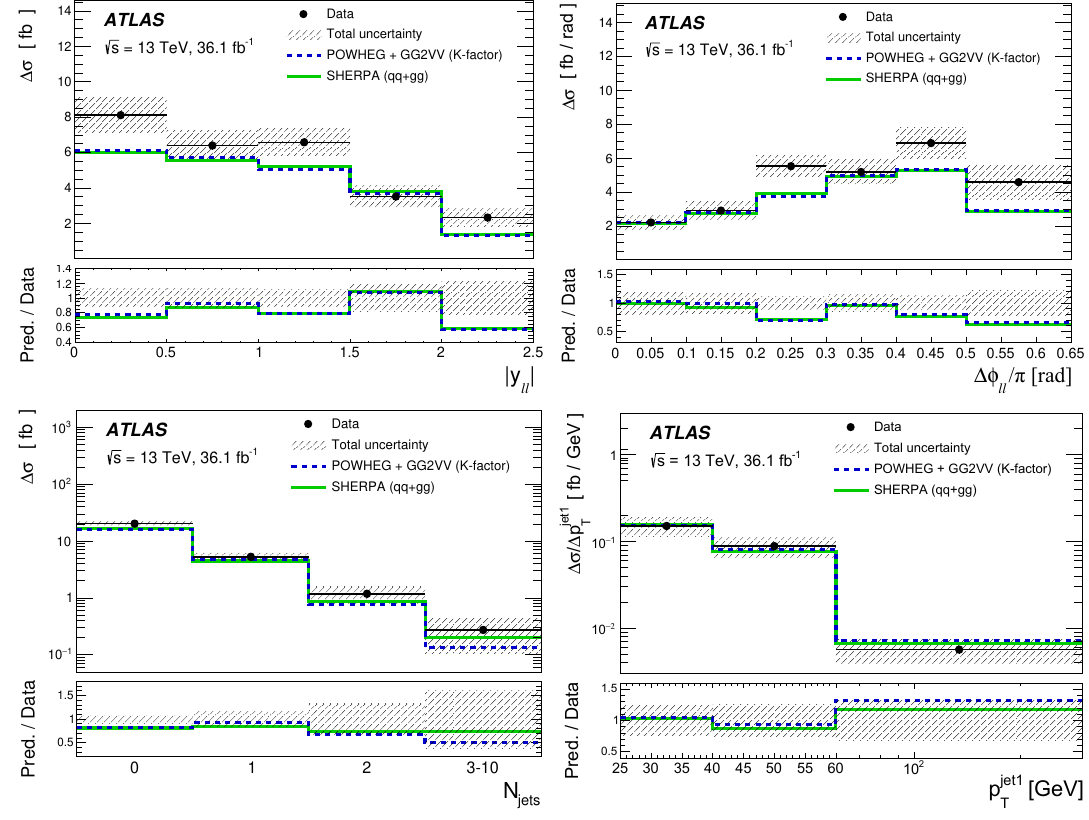
Figure 7 . The measured di(cid:11)erential cross-sections for y (top left), (cid:1) (cid:30) (top right), N ‘‘ j ‘‘ jets j (bottom left), and p jet1 (bottom right) in the (cid:12)ducial region. The hashed bands in light grey T give the total uncertainty. Also shown are the predictions as obtained from Sherpa (solid line) and Powheg+gg2vv (dashed line) with higher-order K -factors, as described in section 3. The last bin in the distributions of N and p jet1 is shown using a di(cid:11)erent x -axis scale for better jets T